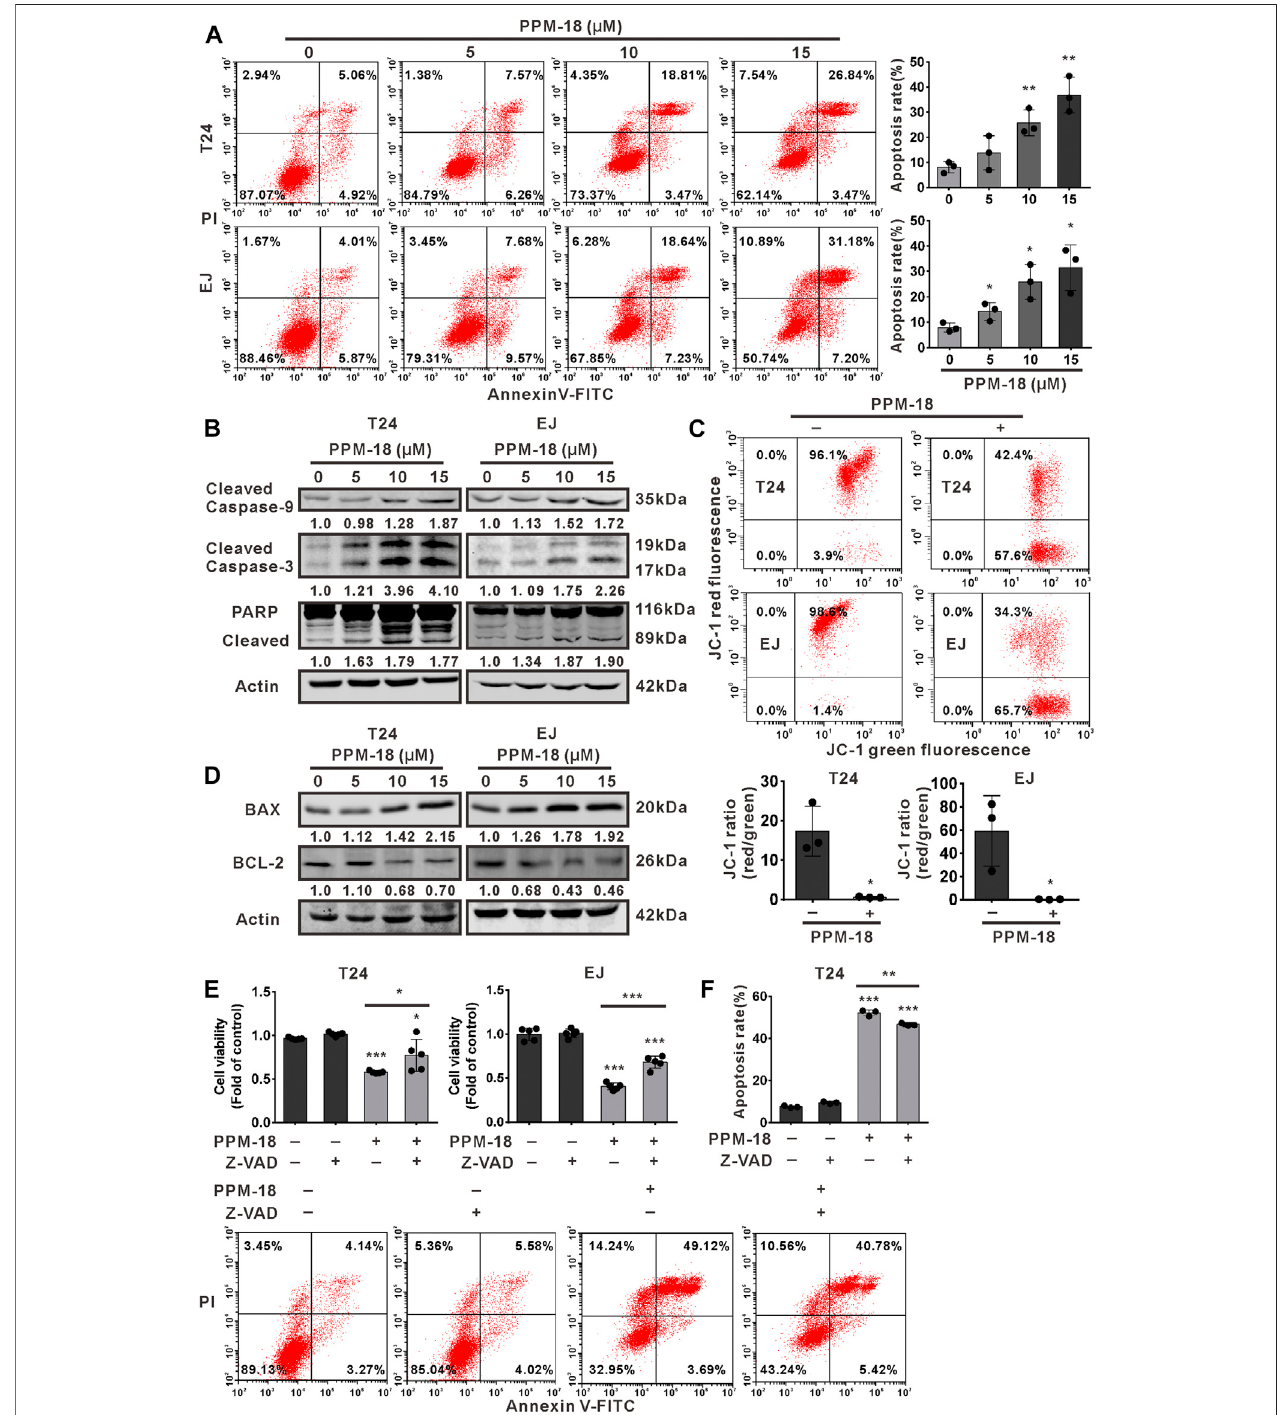
FIGURE2| PPM-18triggersapoptoticcelldeathinbladdercancercells. (A) T24andEJcellsweretreatedwiththeindicatedconcentrationofPPM-18,andstained withannexinV-FITCandPI.Theapoptotic effect ofPPM-18onT24and EJcellswasmeasuredby fl owcytometry. (B) Western blottingshowedtheeffectofPPM-18 on theexpression ofcleavedcaspase-9,3,andPARPinT24andEJcells. (C) T24andEJcellswereexposedto10 μ MPPM-18for24 h,andstainedwithJC-1 fl uorescent probe. The effect of PPM-18 on the alteration of mitochondria membrane potential was analyzed by fl ow cytometry. (D) Western blotting displayed the effect of PPM-18 on expression of BAX and BCL-2 in T24 and EJ cells. (E) and (F) The effect of Z-VAD-FMK on PPM-18 reduced the viability of T24 and EJ cells, or PPM-18 triggered apoptosis in T24 cells. Cells treated with 15 μ M PPM-18 combined with or without 20 μ M Z-VAD-FMK for 24 h, and cell viability and apoptosis were respectively measured by MTS assay and fl ow cytometry. Data are presented as the mean ± SD of at least three independent experiments. * p < 0.05, ** p < 0.01, and *** p < 0.001 vs. the control group, or vs. PPM-18+Z-VAD-FMK.